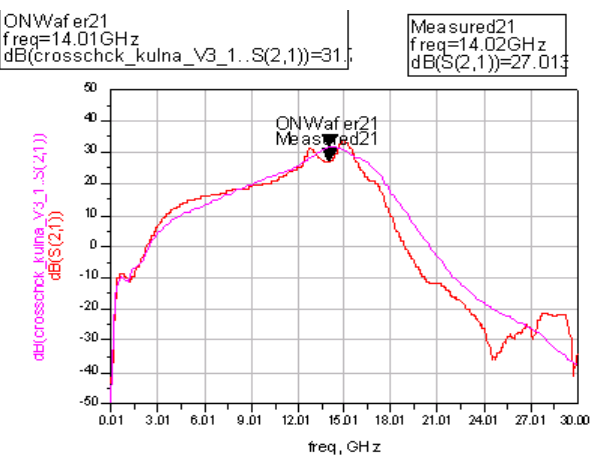
Figure 2: Cavity resonance effect on S21 (Gain of LNA): Comparison of on wafer and measured S21 (dB) with package/housing